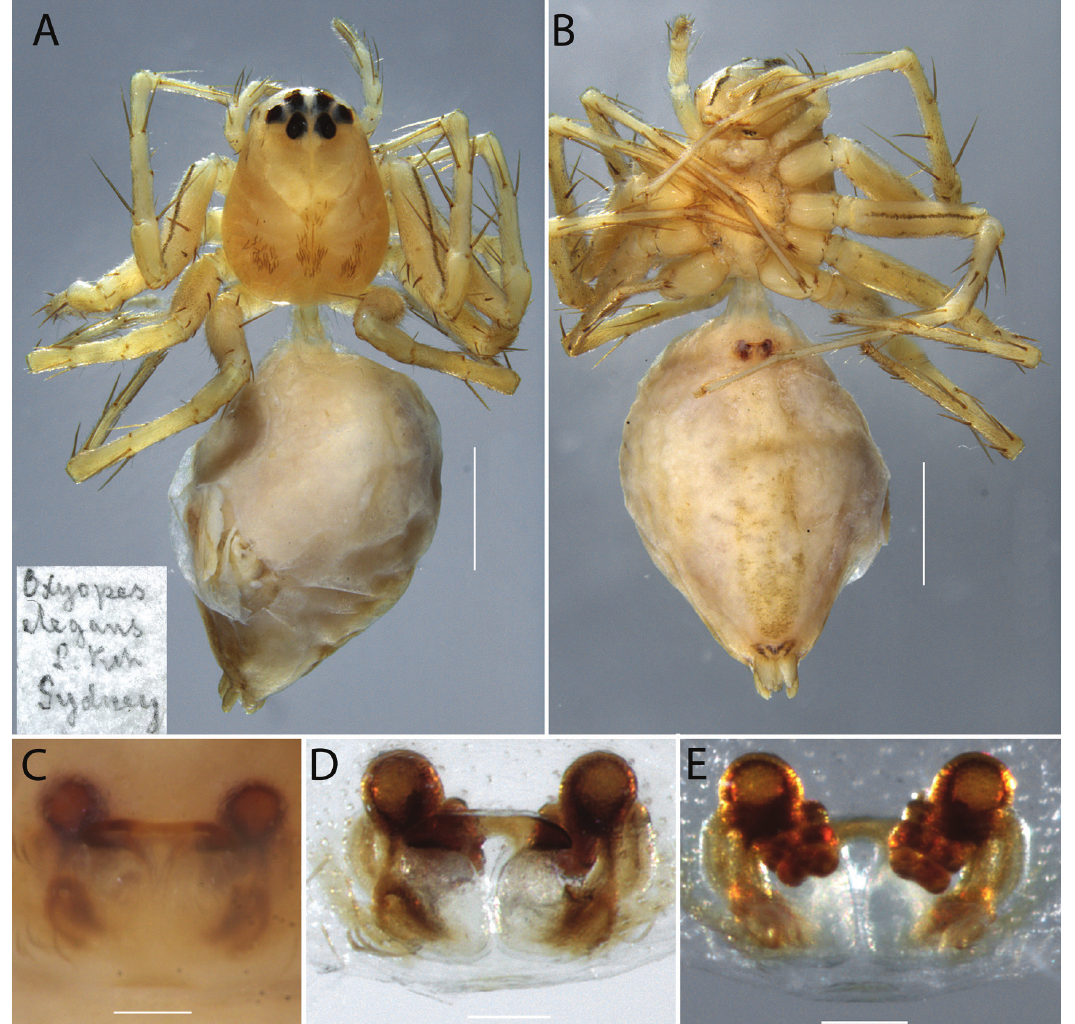
Figure 6. Oxyopes elegans L. Koch, 1878, female lectotype (ZMH- A0000006): A , habitus, dorsal view; B , habitus, ventral view; C , epigyne, ventral view; D, epigyne, ventral view, cleared; E , epigyne, dorsal view, cleared. Scale bars: habitus 1.0 mm, epigyne 0.1